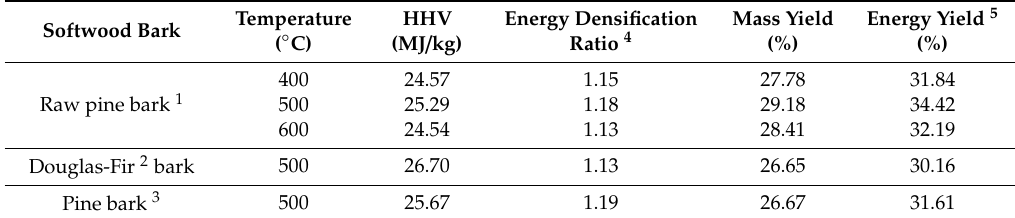
Table 2. Higher heating value (HHV), energy densification ratio, mass and energy yield of pyrolysis oil produced from raw pine bark, pine, and Douglas-Fir bark.